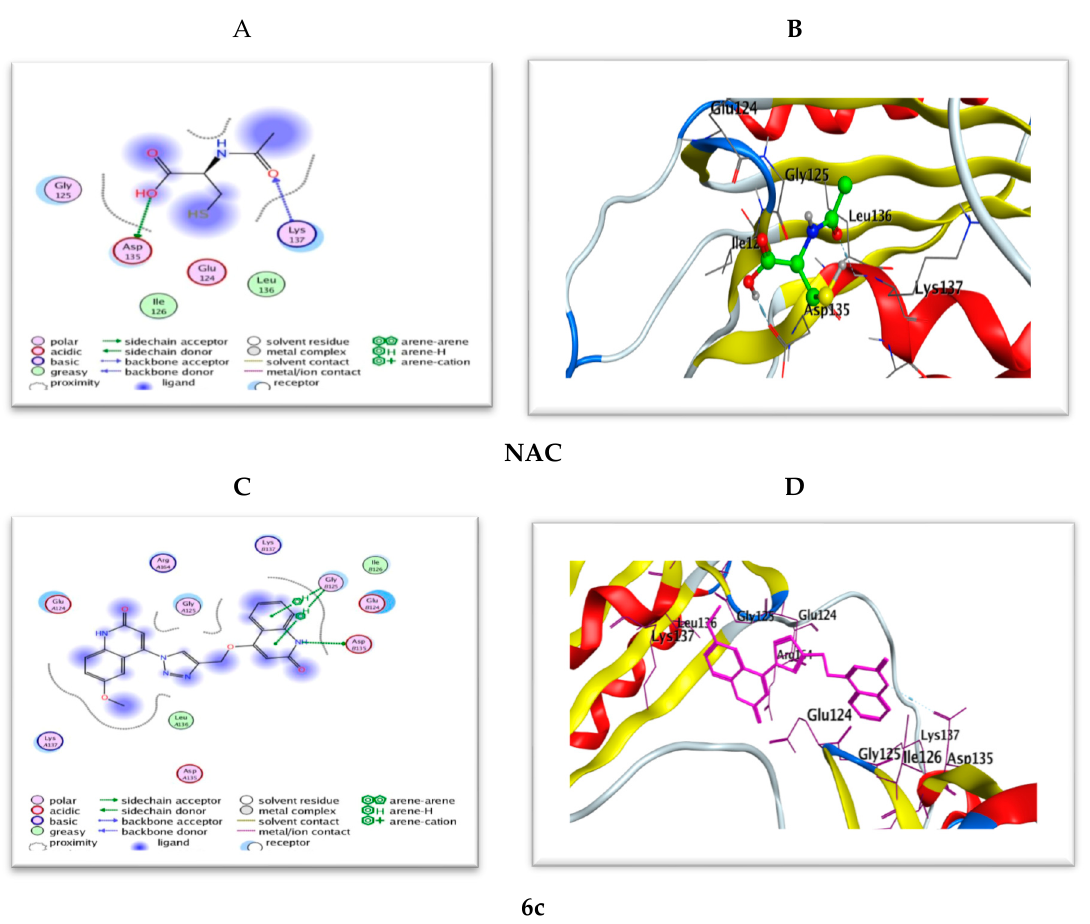
Figure 14. ( A , B ) 2D and 3D diagrams illustrate the binding modes of the reference NAC and ( C , D ) are for 6c interacted with the active site of caspase-3 (PDB: